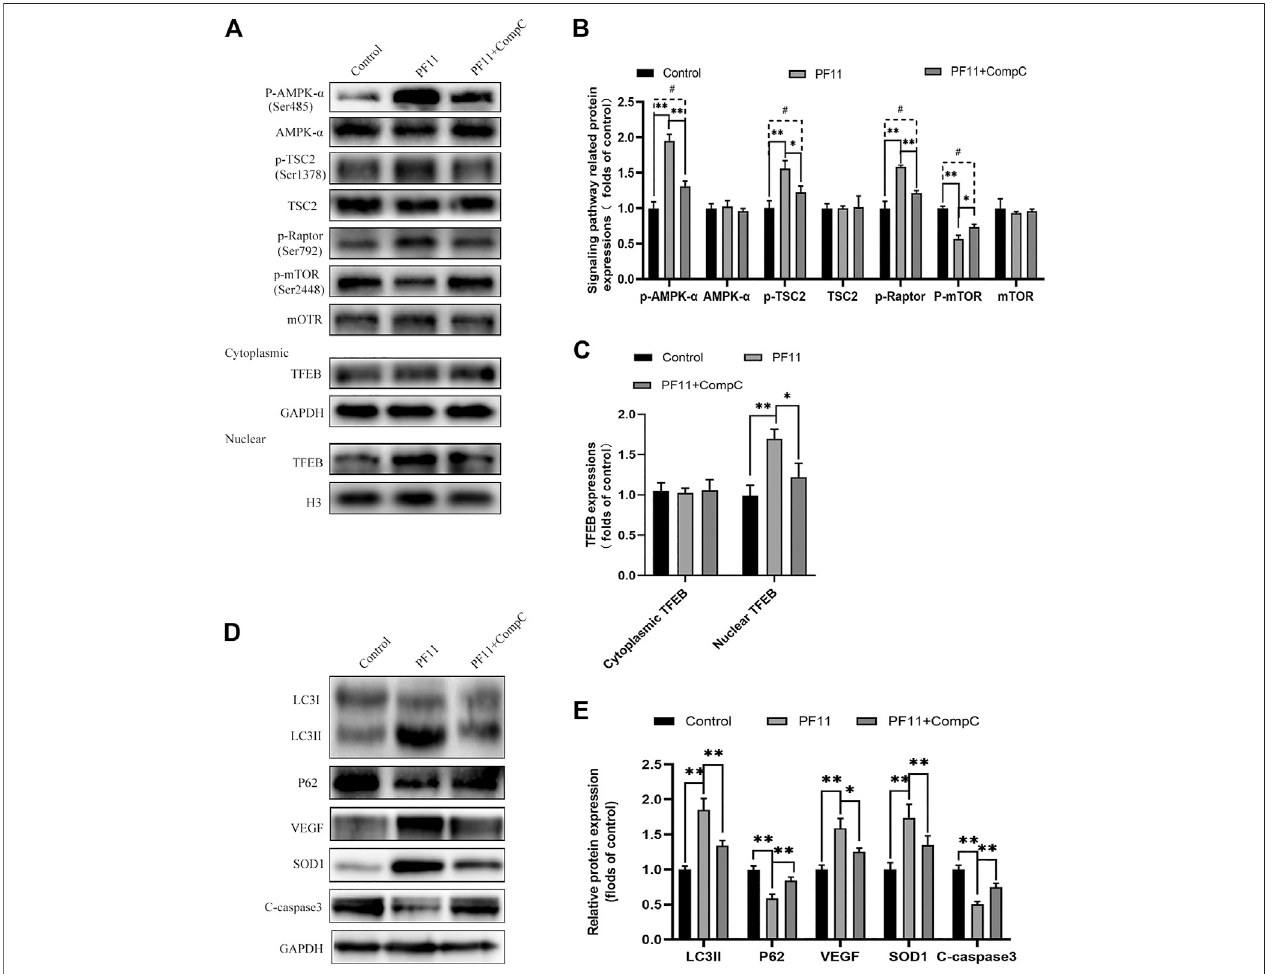
FIGURE 8 | PF11 regulates AMPK-mTOR signaling pathway in fl aps. (A – C) Western blotting results showed the expression of AMPK- α , p-AMPK- α , TSC2, p-TSC2, p-Raptor mTOR, p-mTOR, cytoplasmic TFEB, and nuclear TFEB in the control, PF11, and PF11 + CC groups. (D,E) Expression and quanti fi cation of LC3II, p62,VEGF,SOD1,andC-caspase3ineachgroup.Valuesareexpressedasmeans ± SD, n (cid:2) 6pergroup.* p < 0.05and** p < 0.01,vs.PF11group.# p < 0.05and## p < 0.01, vs. control